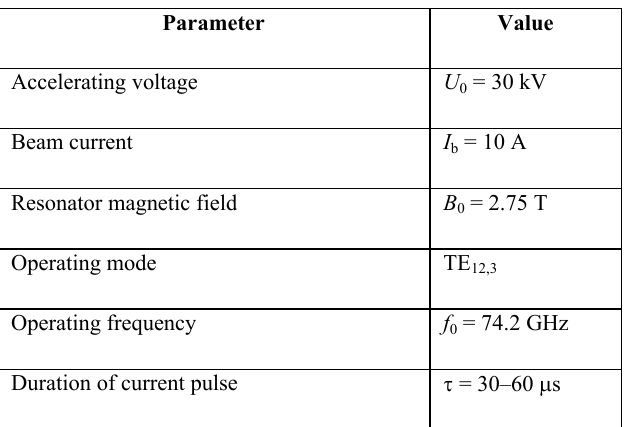
Table 1. Parameters of the SPbPU gyrotron.